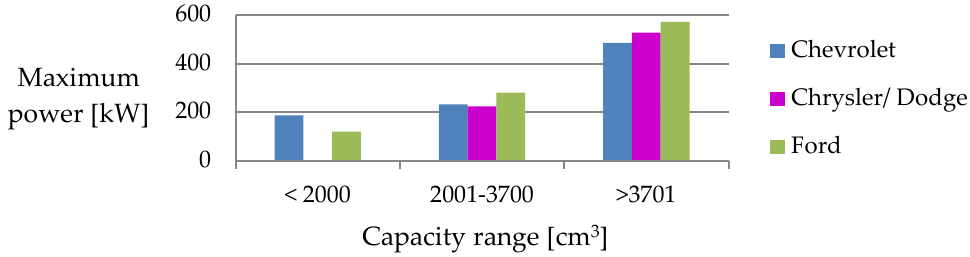
compartments; European and Asian car brands. Source: Developed own.